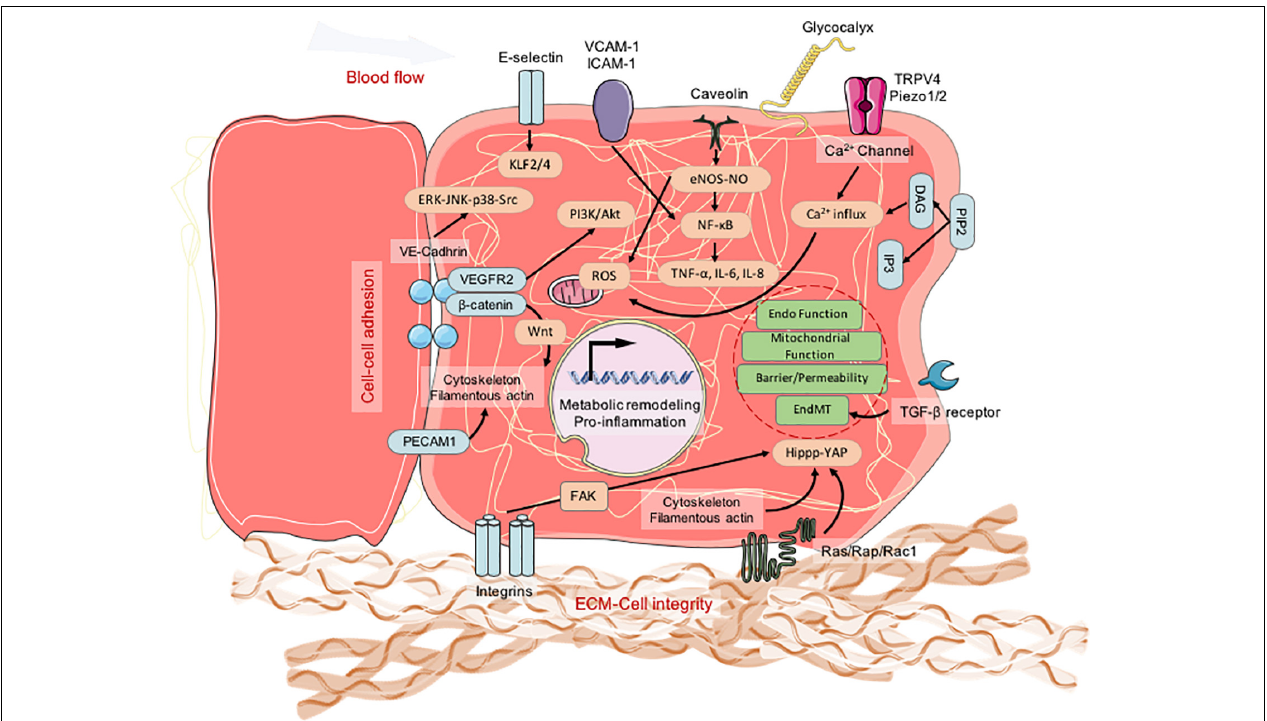
FIGURE 3 | The molecular signaling of mechanotransduction in pulmonary blood vessel endothelial cells. ECM, extracellular